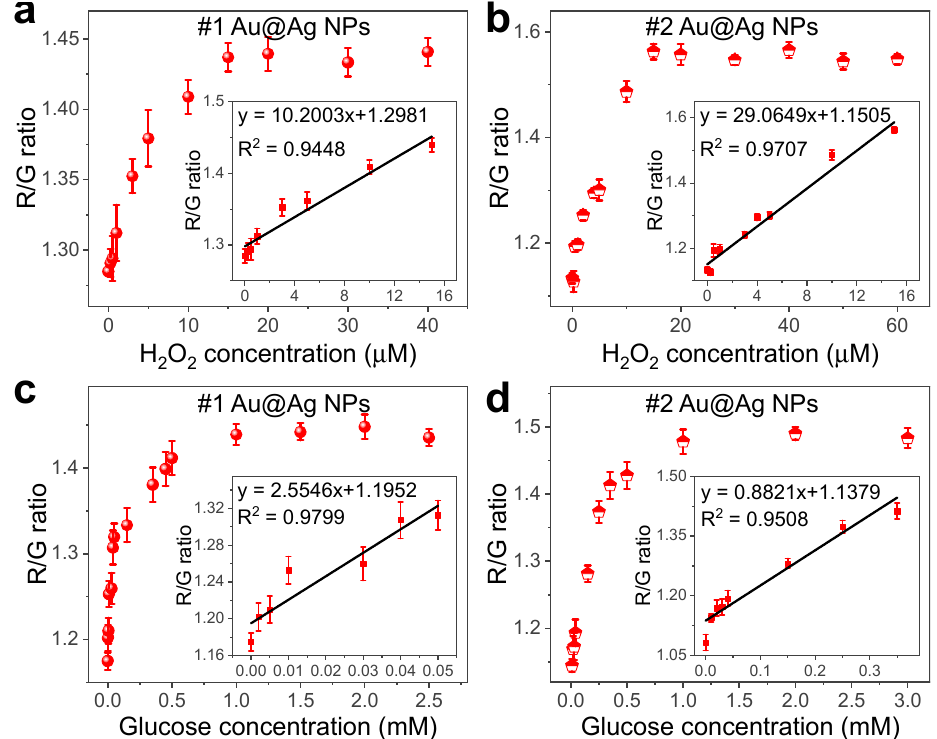
Figure 4. Sensitive detection of H 2 O 2 and glucose with Au@Ag NPs at different shell thicknesses. ( a , b ) Response curves of R/G ratio toward various concentrations of H 2 O 2 on ( a ) #1 and ( b ) #2 Au@Ag NPs samples. ( c , d ) Response curves of R/G ratio toward various concentrations of glucose on ( c ) #1 and ( d ) #2 Au@Ag NPs samples. A GOx concentration of 0.05 mg·mL − 1 and pH of 7.0 were used for the sensing of glucose.